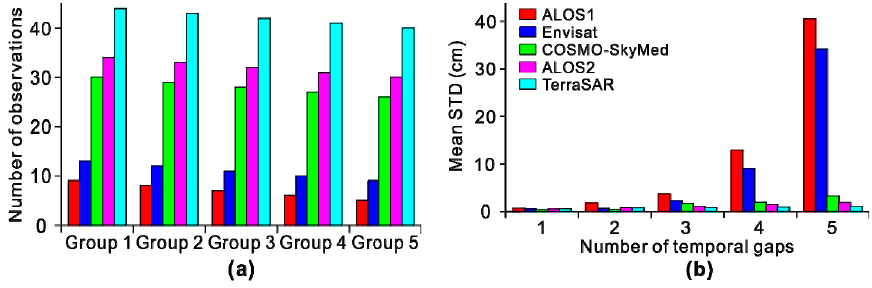
Figure 3. ( a ) Number of simulated InSAR observations with different numbers of temporal gaps, where Groups 1 − 5 contain 1 − 5 temporal gaps, respectively. ( b ) Mean STDs of the differences between the simulated dynamic subsidence and the subsidence estimated from the InSAR observations with temporal gaps using the proposed method.